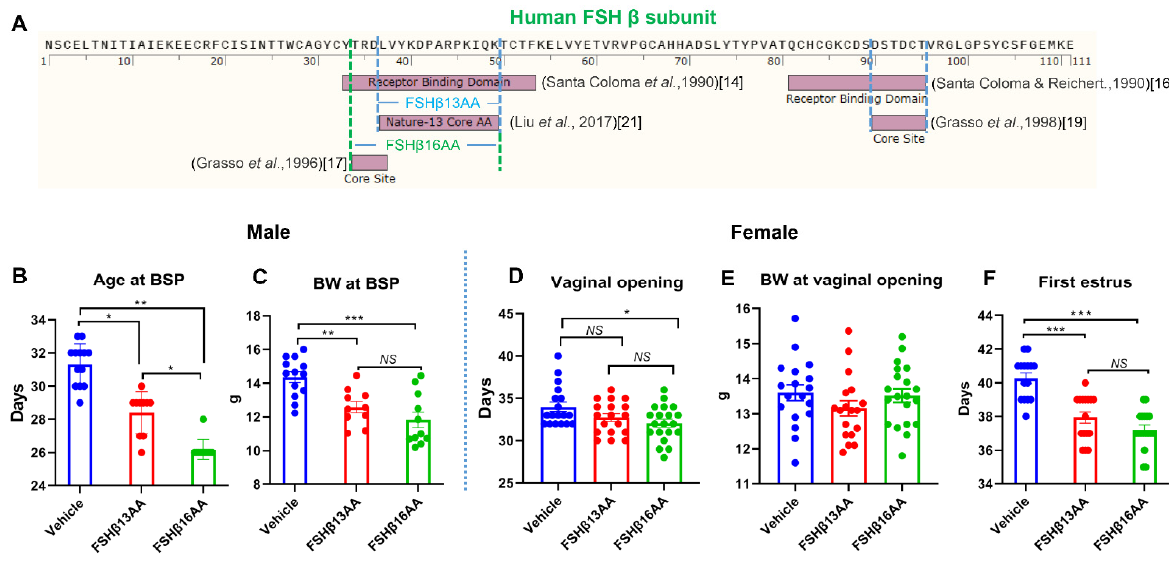
Figure 1. FSH β 13AA/FSH β 16AA hastens puberty in male and female mice. ( A ) Timeline in the identification of the receptor-binding sites of human (h) FSH β subunit. In 1990, two regions corresponding to hFSH- β -(33–53) [14] and hFSH- β -(81–95) [16] were identified as receptor binding sites. Later, within the two larger receptor-binding domains of the hFSH- β -subunit, a subdomain with four amino acid residues 34–37 (TRDL) [17] within hFSH- β -(33–53), and another subdomain with six amino acid residues 90–95 (DSTDCT) [19] within hFSH- β -(81–95) were identified as core binding determinants. In 2017, Liu et al. reported the receptor binding site of the hFSH- β -subunit was a 13-amino acid sequence (33–53), referred to as Nature-13 core AA, as this discovery was published in Nature [21]. ( B ) A single treatment (200 µ g/g BW) of either FSH β 13AA or FSH β